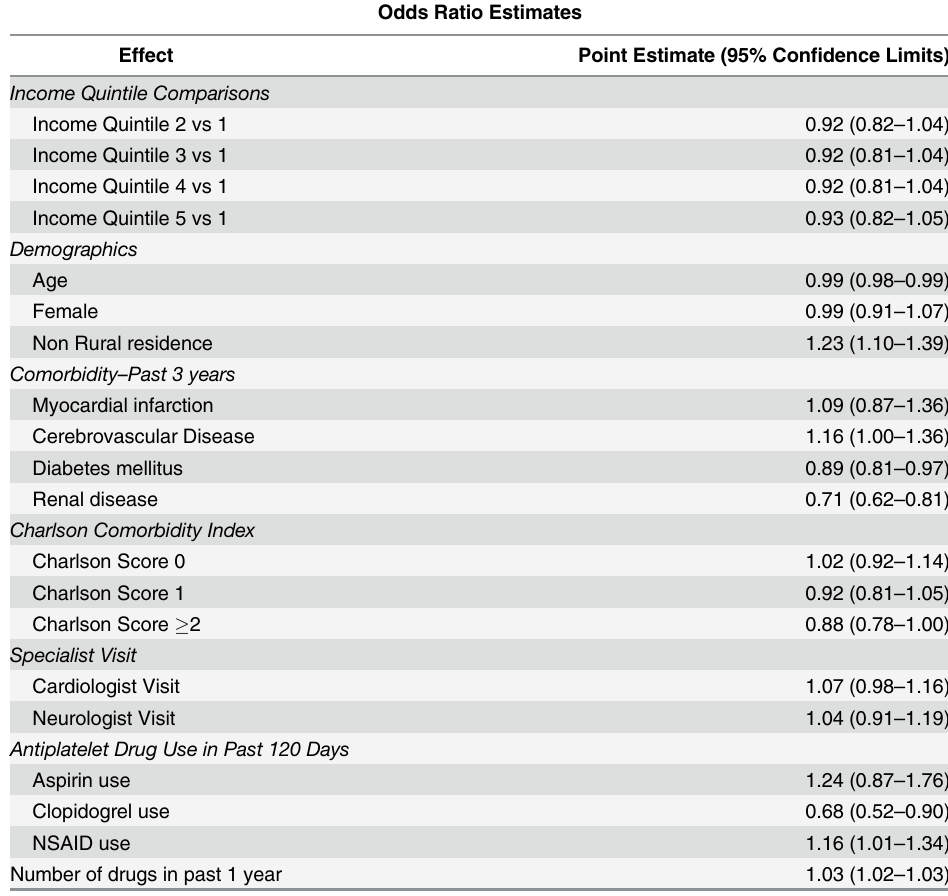
Table 2. Secondary Analysis: Odds of Switching to Dabigatran after ODBP listing of Dabigatran – Adjusted